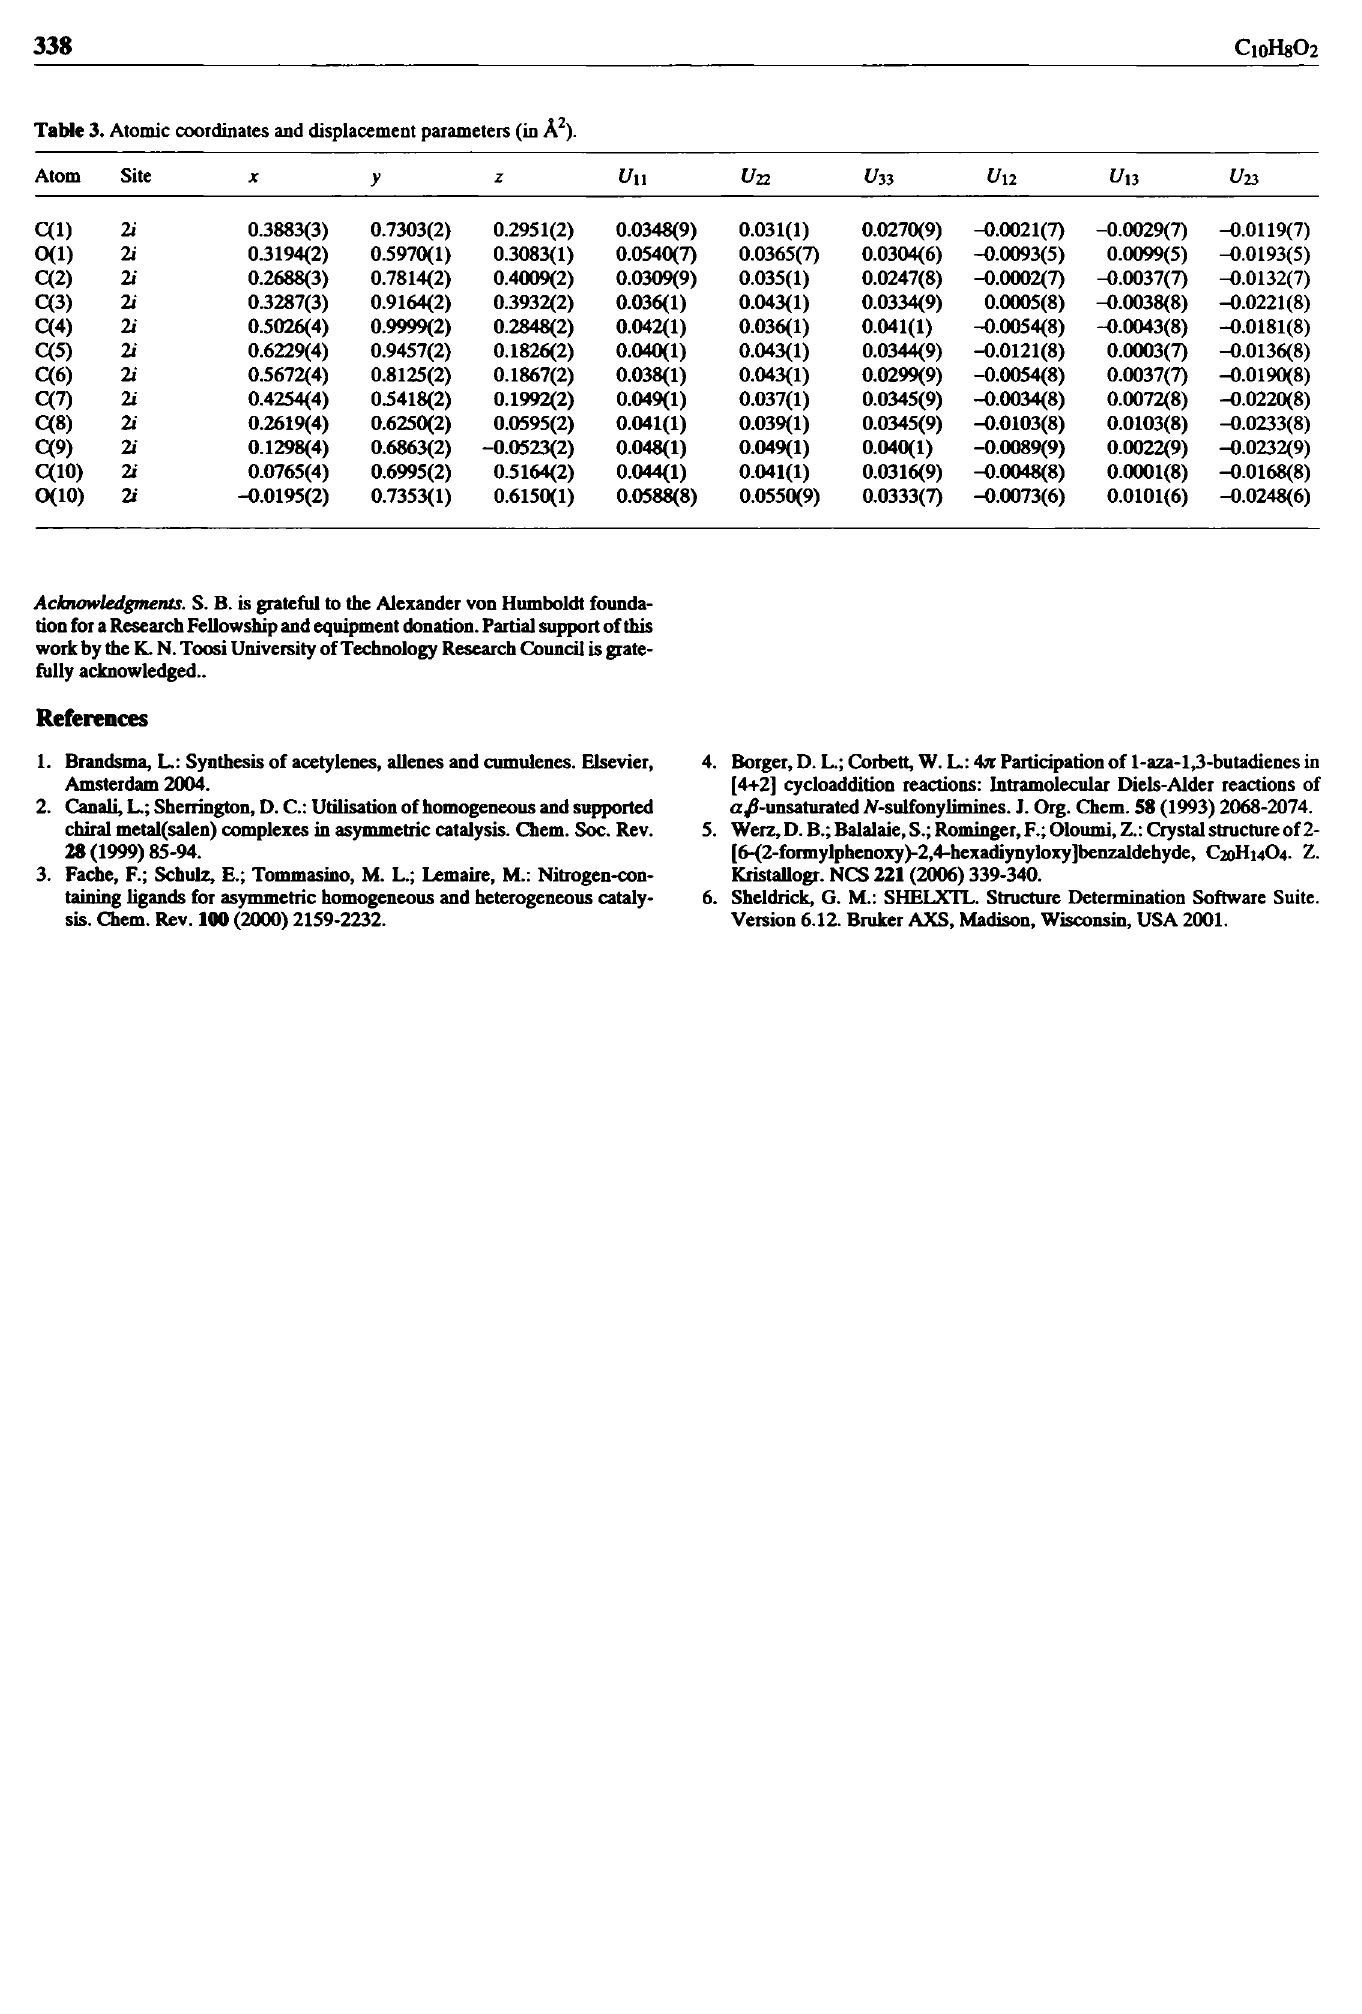
Table 3. Atomic coordinates and displacement parameters (in A 2